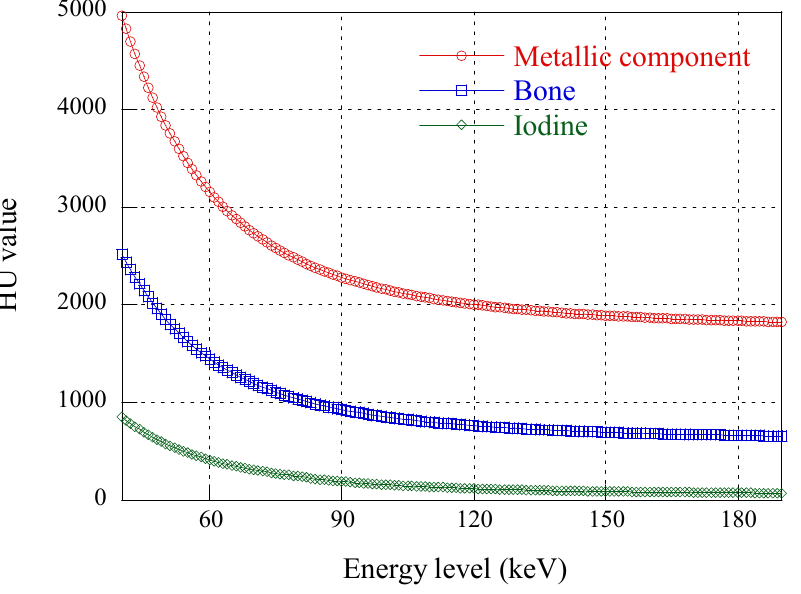
Figure 2. HU values plotted with metallic component, bone, and iodine in the range of 50 keV to 190 keV.